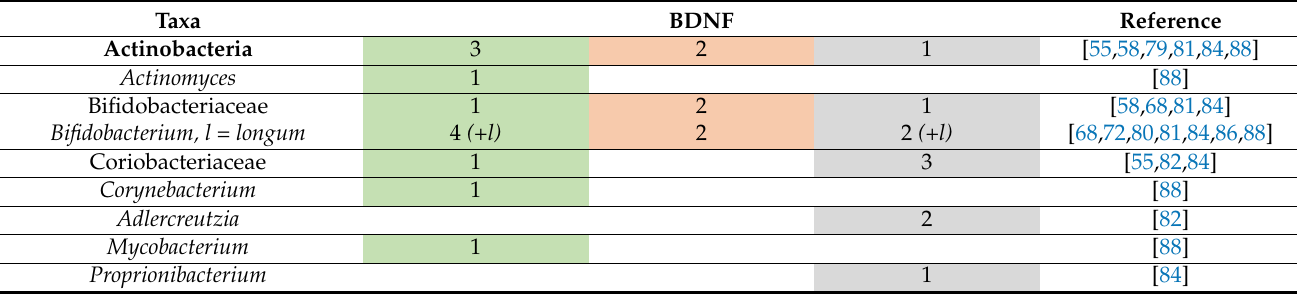
Table 10. Actinobacteria and